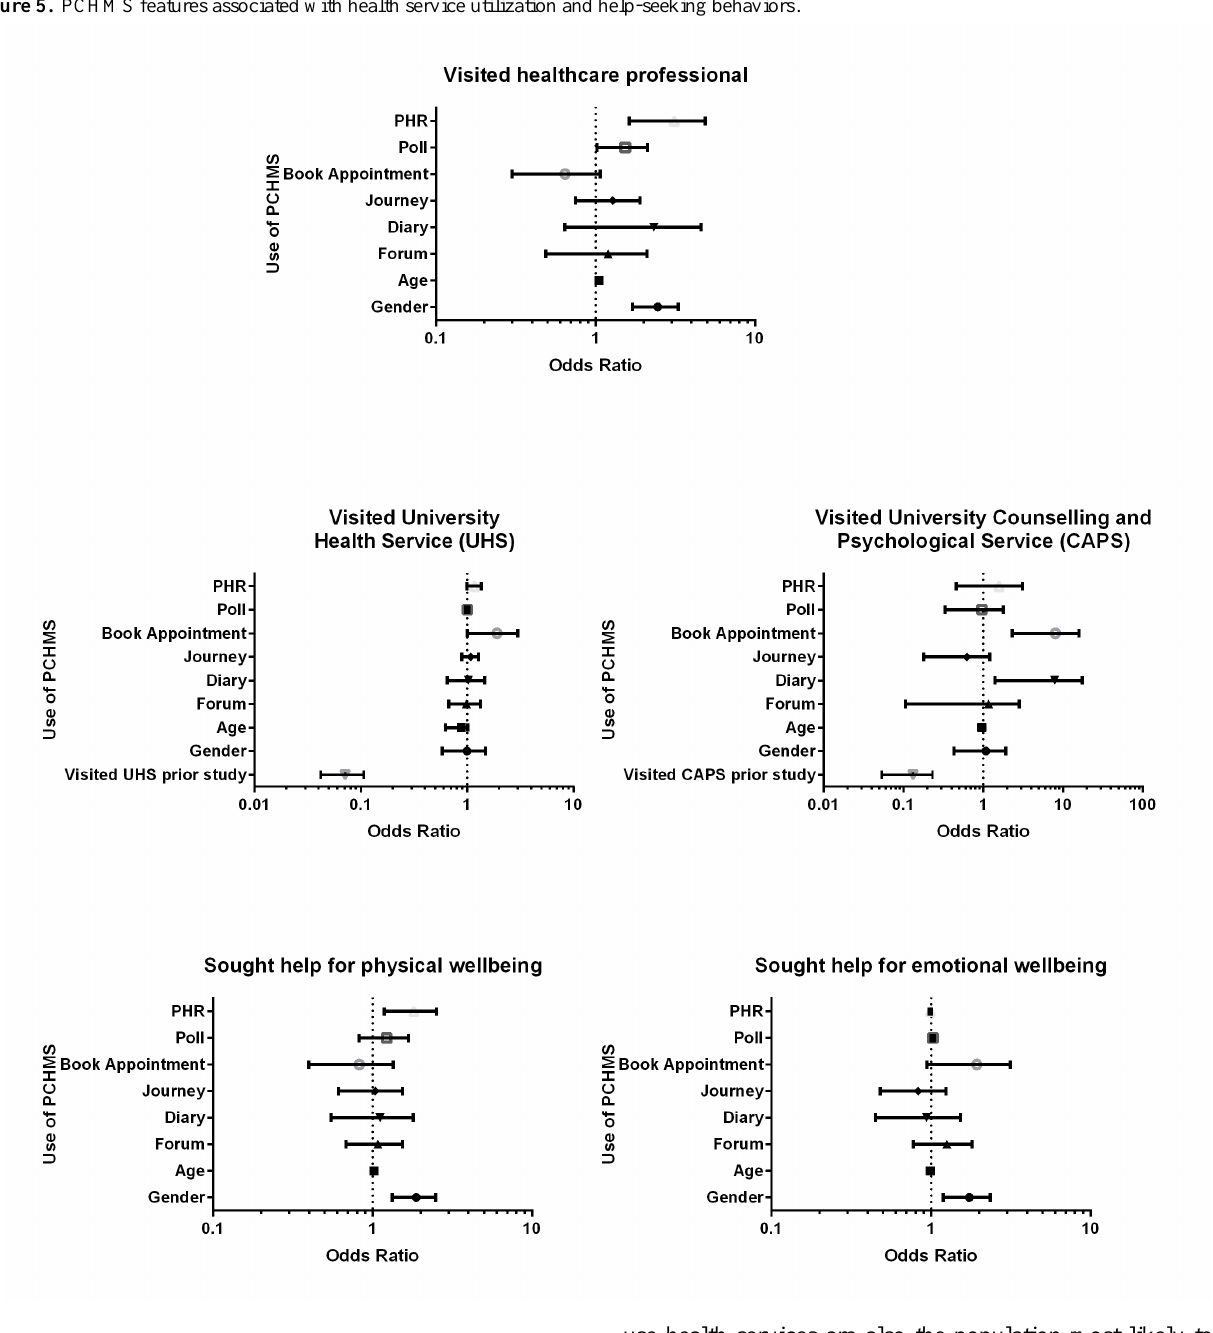
Figure 5. PCHMS features associated with health service utilization and help-seeking